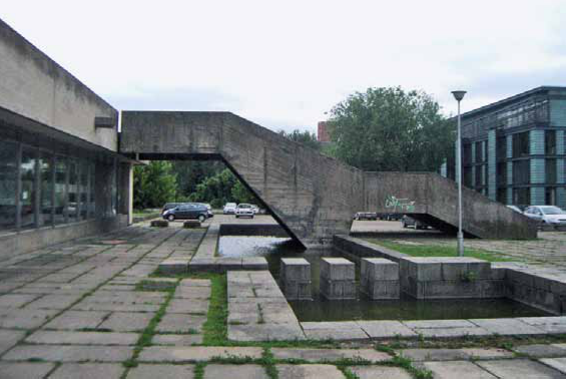
vaizdo fragmentas su įeigos tiltu. a. novicko nuotr. Fig. 3. View of Vilnius art Institute‘s (Vilnius art academy at present) new building with the entrance bridge. a. novickas